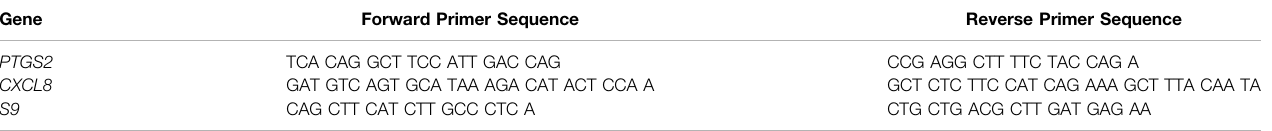
TABLE 1 | Primer sequences used for qRT-PCR analysis. Gene Forward Primer Sequence Reverse Primer Sequence